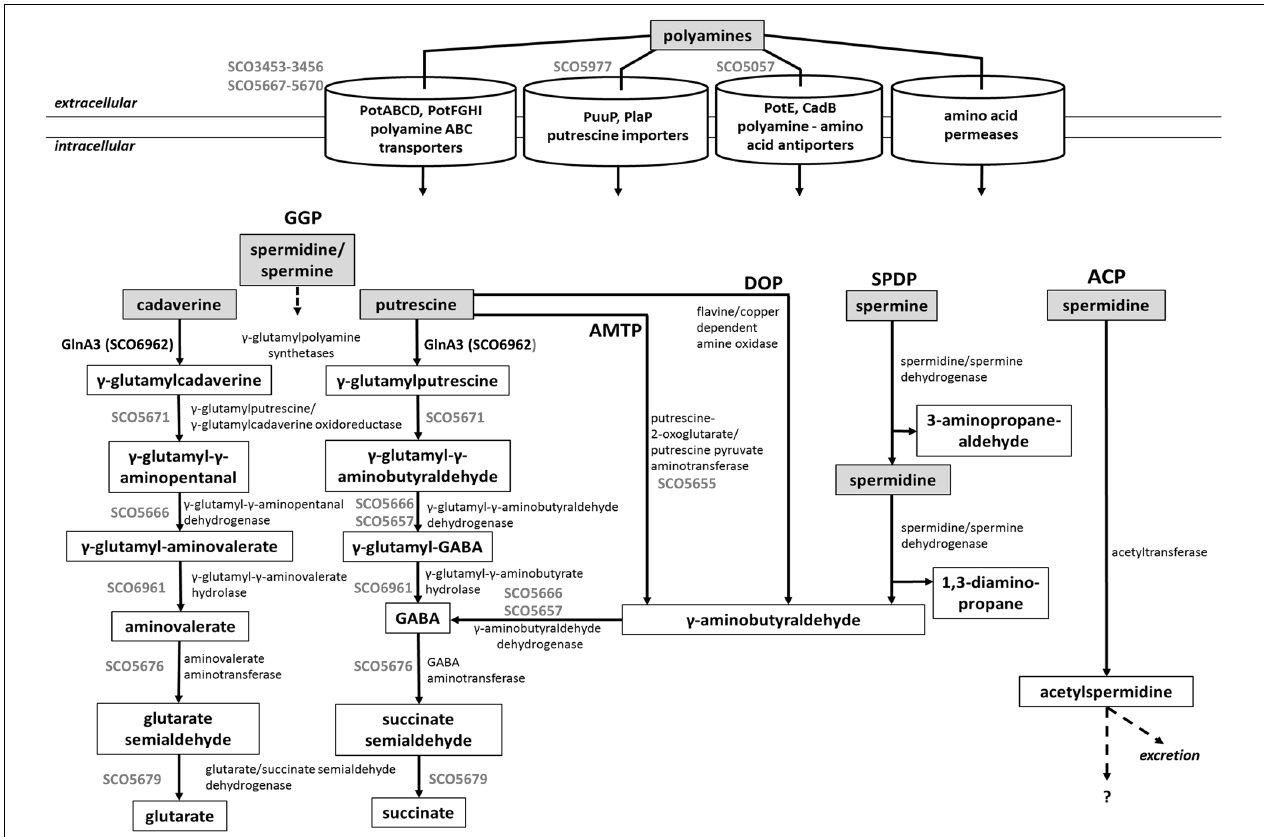
FIGURE 1 | Combined model of polyamine utilization pathways within prokaryotes based on published studies (Yao et al., 2011; Schneider and Reitzer, 2012; Foster et al., 2013; Campilongo et al., 2014; Kusano and Suzuki, 2015). GGP, gamma-glutamylation pathway; AMTP, aminotransferase pathway; DOP, direct oxidation pathway; SPDP, spermine/spermidine dehydrogenase pathway; ACP, acetylation pathway. Dashed arrows represent not entirely investigated metabolic pathways. In gray, deduced steps of the polyamine degradation pathway in S. coelicolor